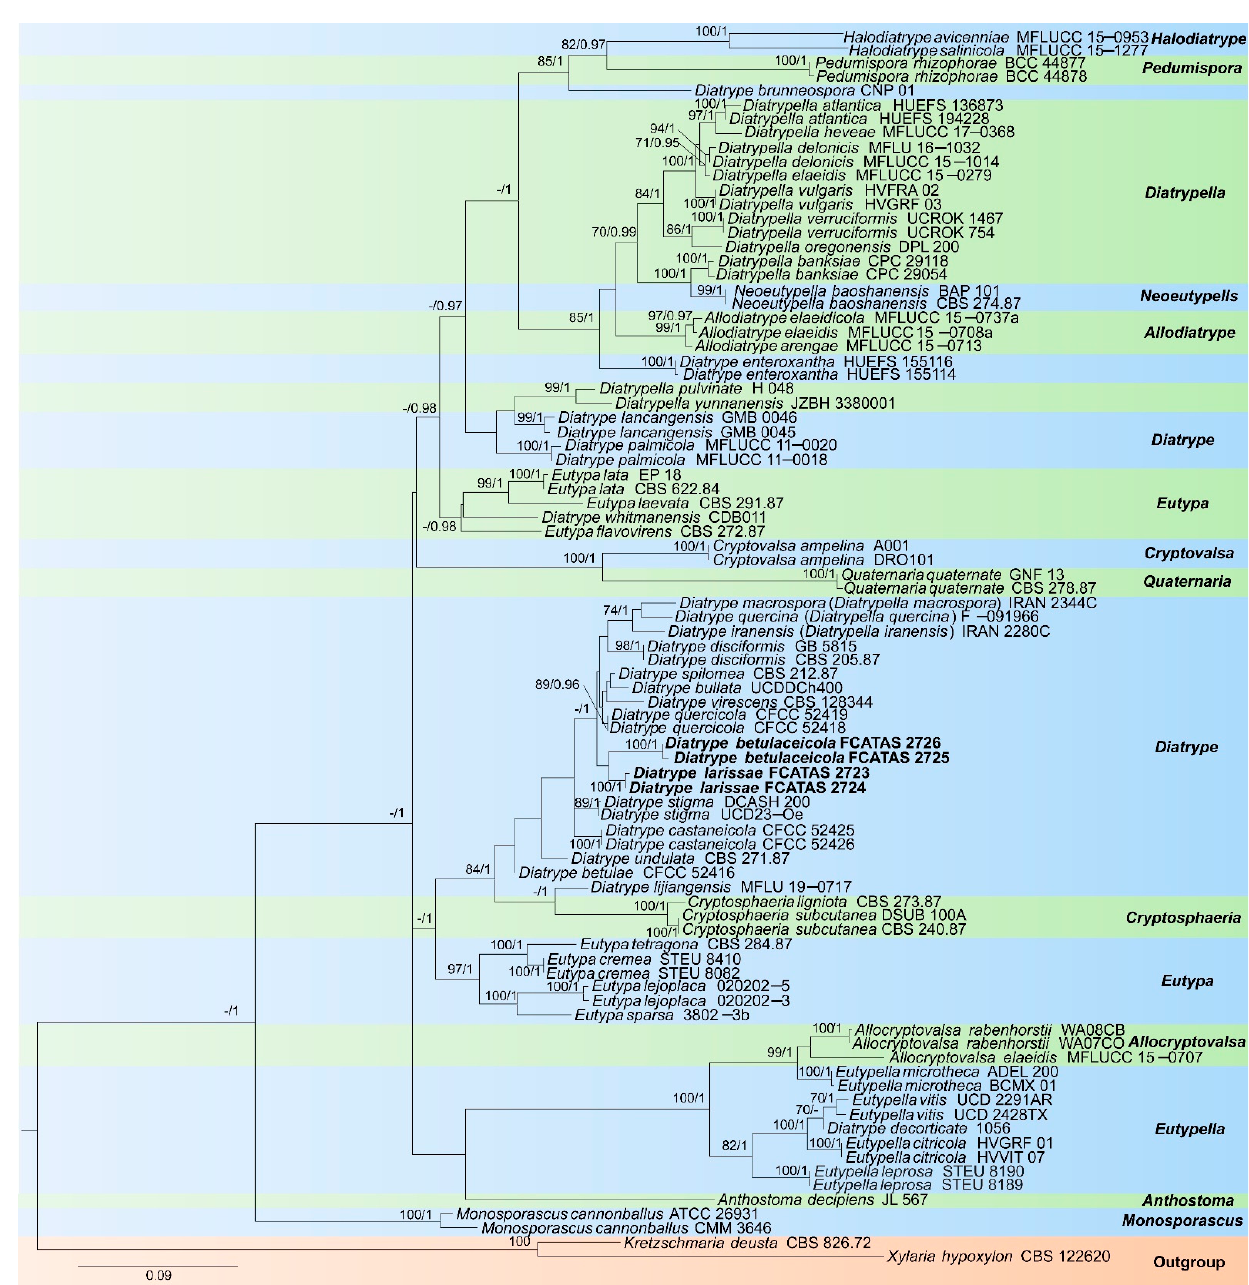
Figure 1. Phylogram generated from Maximum Likelihood (ML) analyses, based on ITS- β -tubulin matrix. Branches are labelled with maximum likelihood bootstrap ≥ 70%, Bayesian posterior proba- bilities ≥ 0.95. New species are labelled in bold.